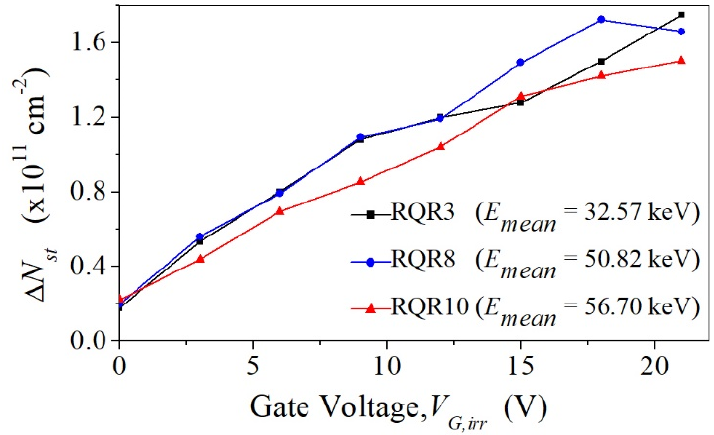
Figure 7. ∆ N st at K air = 50 Gy versus gate voltage during irradiation .